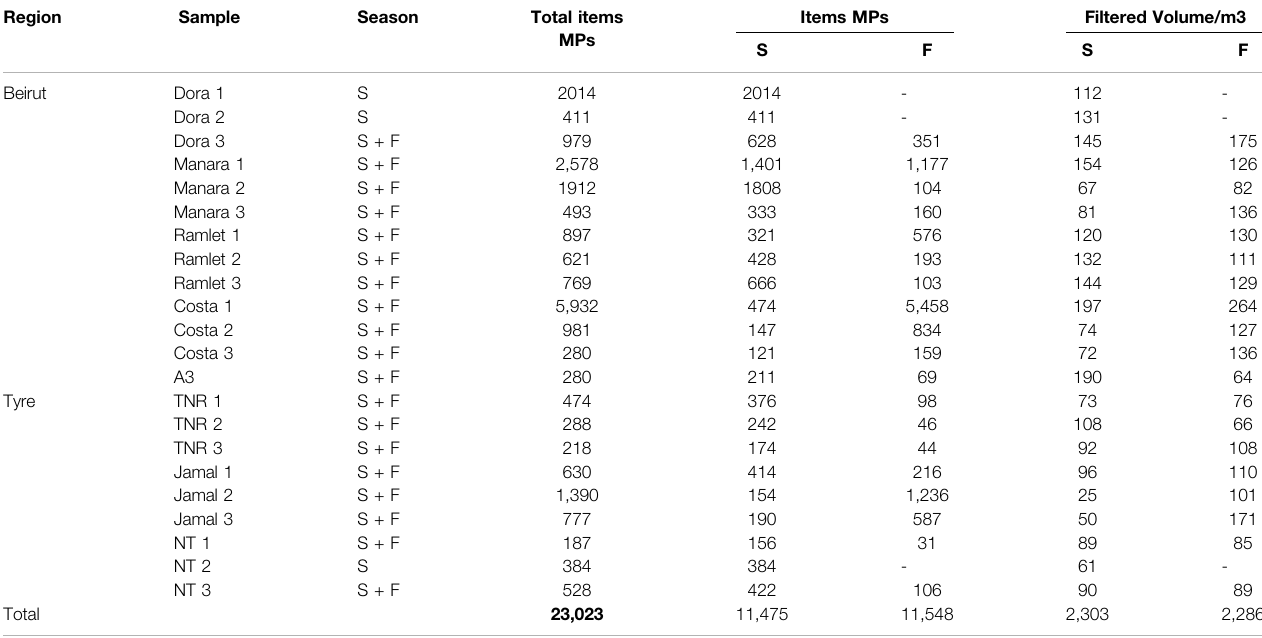
TABLE 1 | The number of items identi fi ed and the volume of fi ltered water for each site during spring and fall (MPs: Microplastics; S: Spring; F: Fall). Region Sample